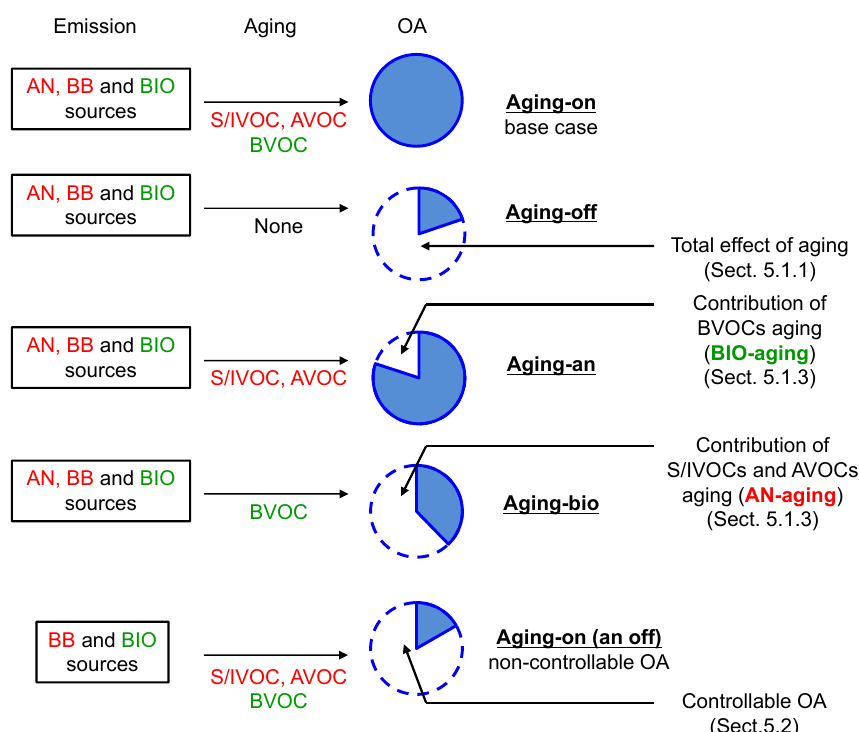
Figure 9. Diagram of sensitivity simulations conducted in Sect. 5. OA contributions estimated from individual simulations are shown. AVOC and BVOC denote anthropogenic and biogenic OVOCs, respectively. Fig. 10